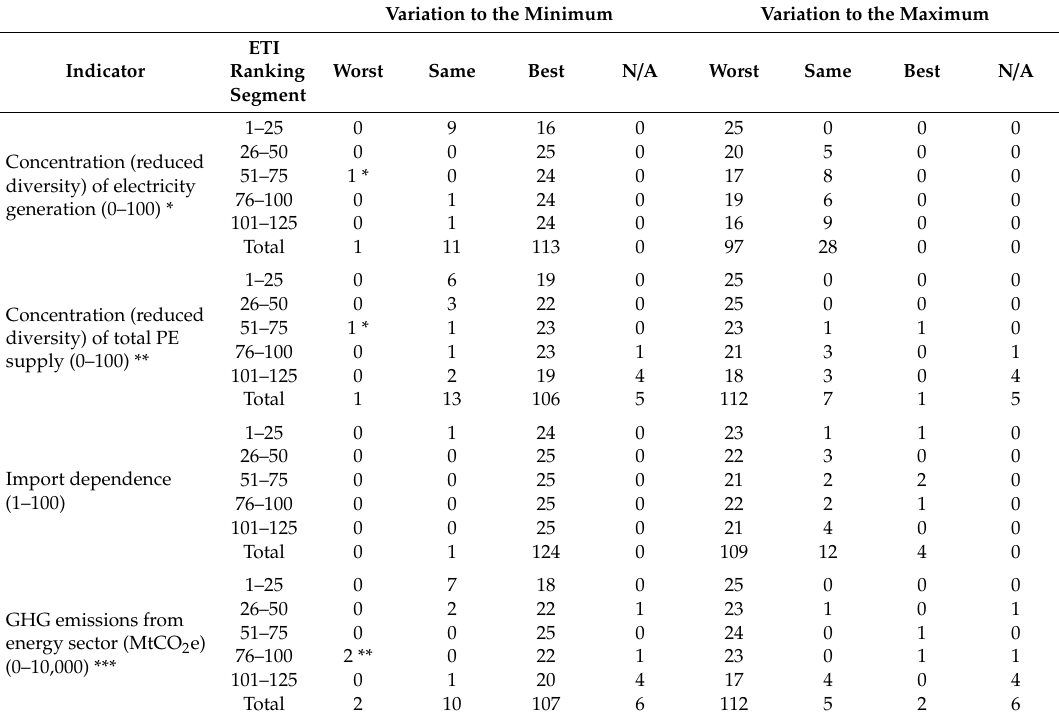
Table 1. Results obtained in indicators of the pathway calculator (WEC). Source: Created by authors using data from